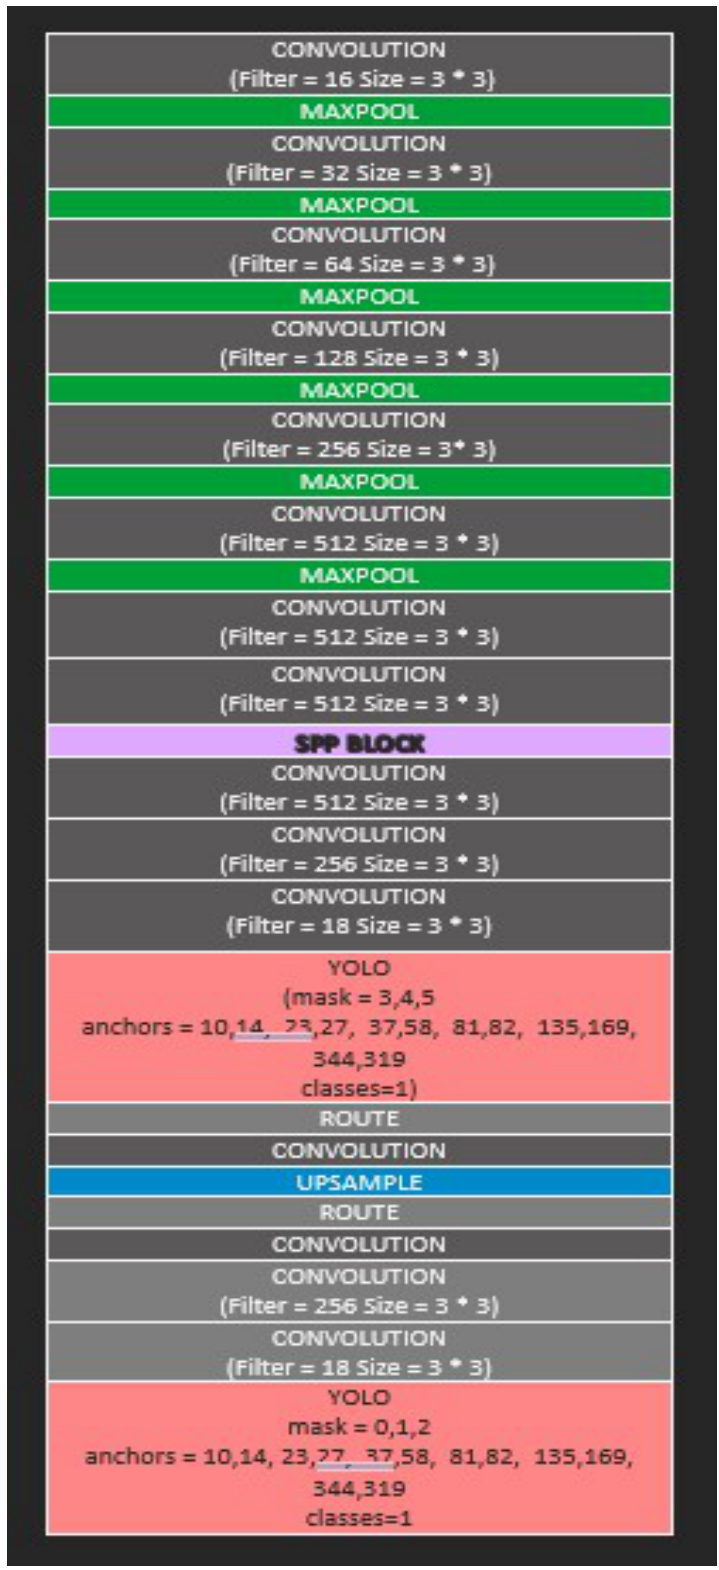
Figure 9. Architecture of our custom YOLOv4-SPP